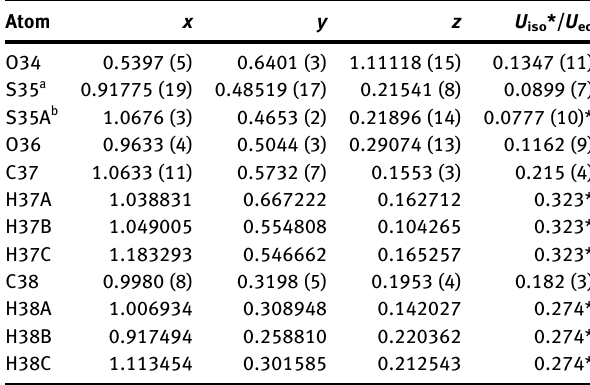
N/O-atoms were located on a difference Fourier map and refined freely. All H atoms bound to aromatic C atoms were placed geometrically (C – H = 0.93 Å) and re fi ned using a riding model with U (H) = 1.2 U (C). All H atoms from the iso eq methyl group were positioned geometrically (C – H = 0.98 Å) and re fi ned using a riding model, with U (H) = 1.5 U (C). iso eq